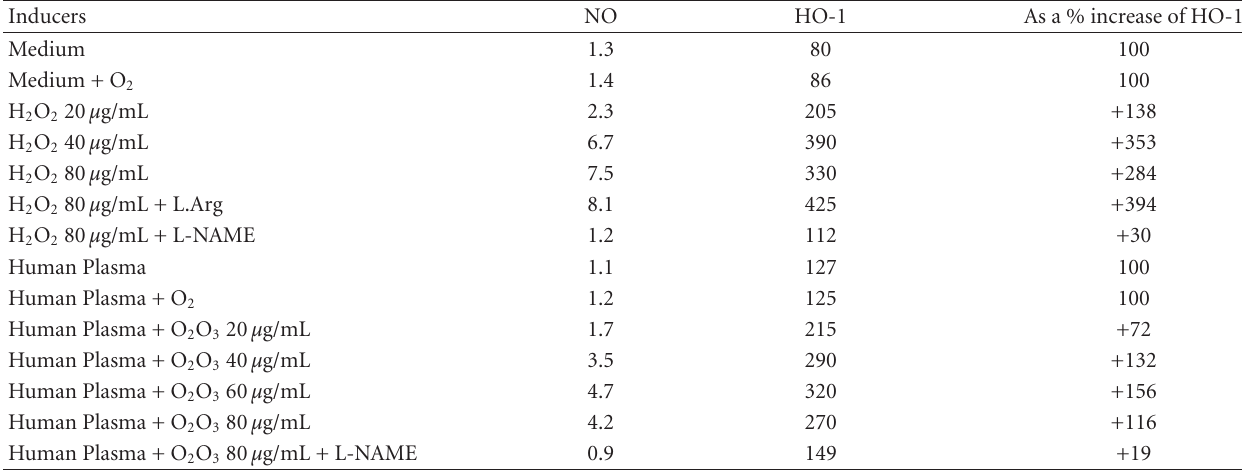
Table 1: Production of NO (as total nitrite, μ M) and HO-1 (as bilirubin, pmol/mg cell protein/1 hour) after stimulation of HUVECs in culture for 18 hours with the indicated inducers. Inducers